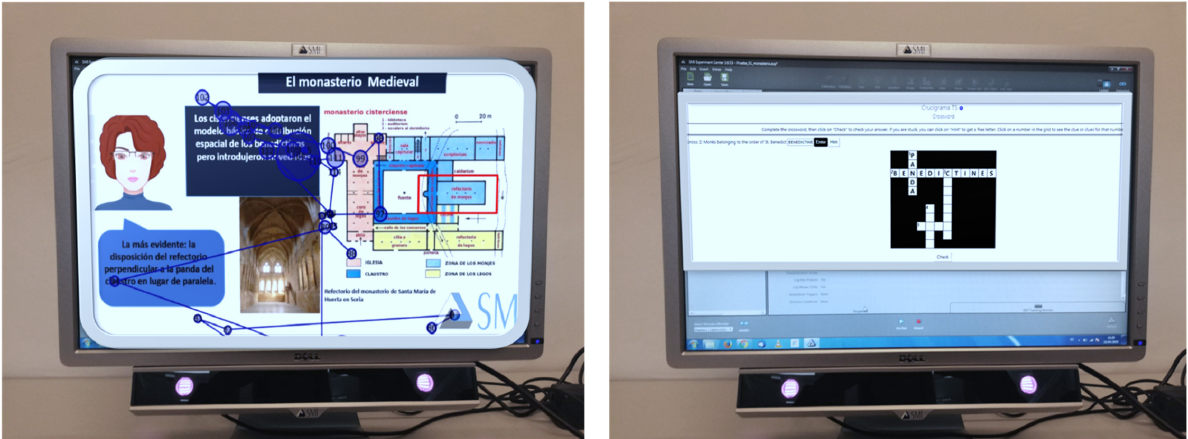
Figure 2. Watching the video and carrying out the crossword puzzle. Note. The circles on the image on the right indicate each point of fixation of the learner on each element in the visual tracking sequence of the image.